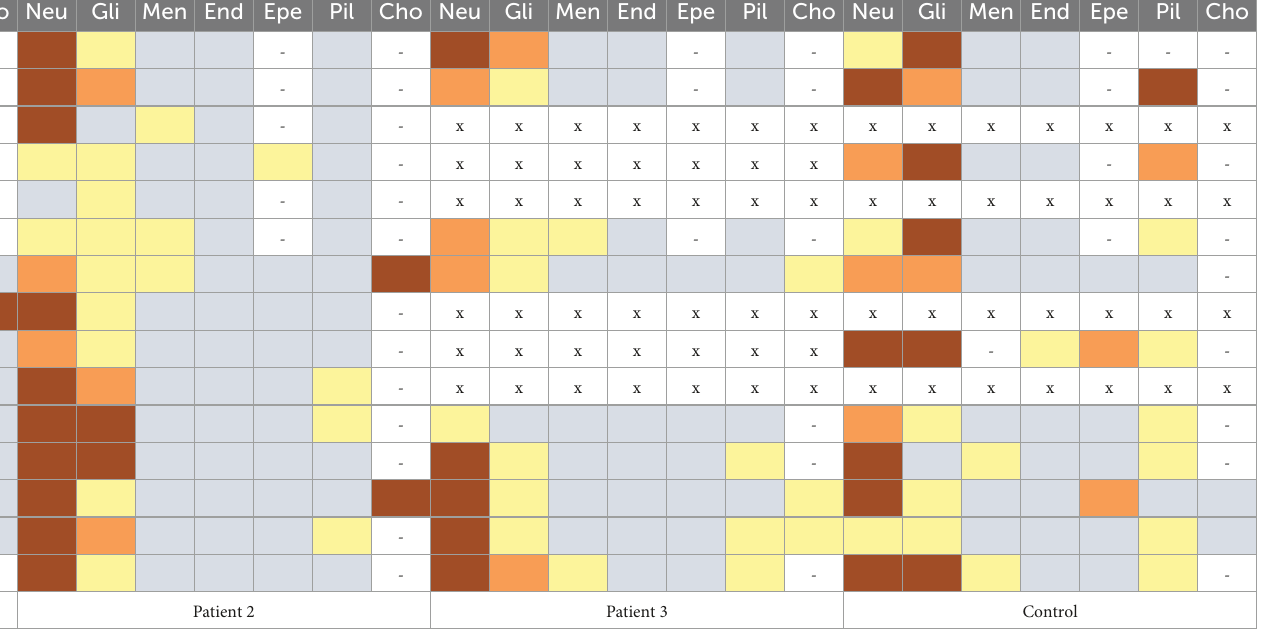
x Notissueavailable. -